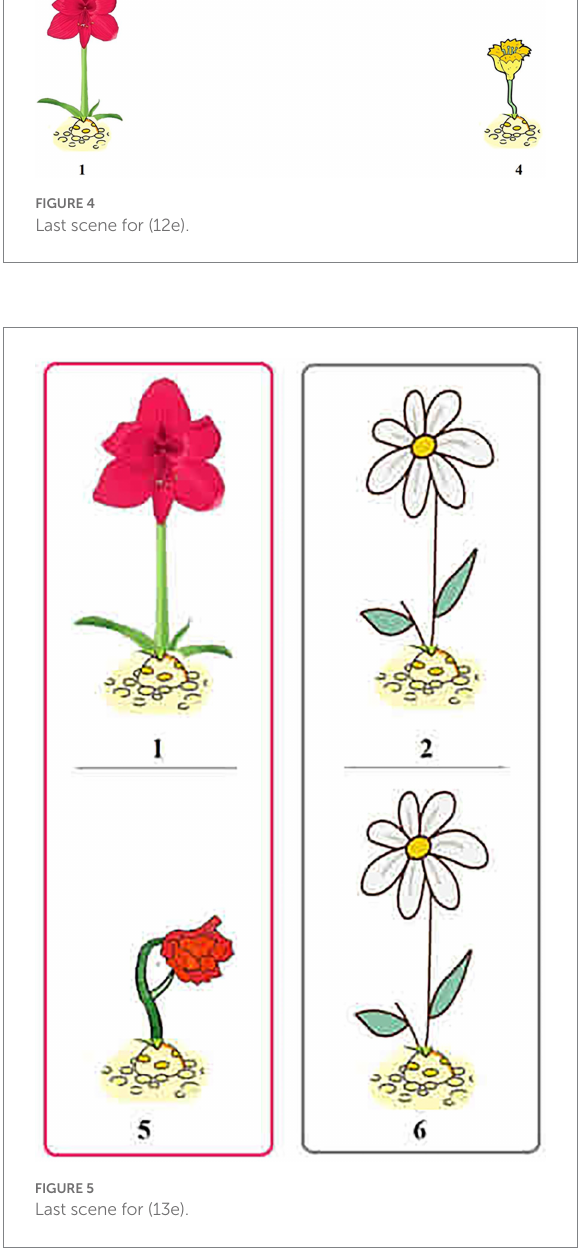
FIGURE 5 Last scene for